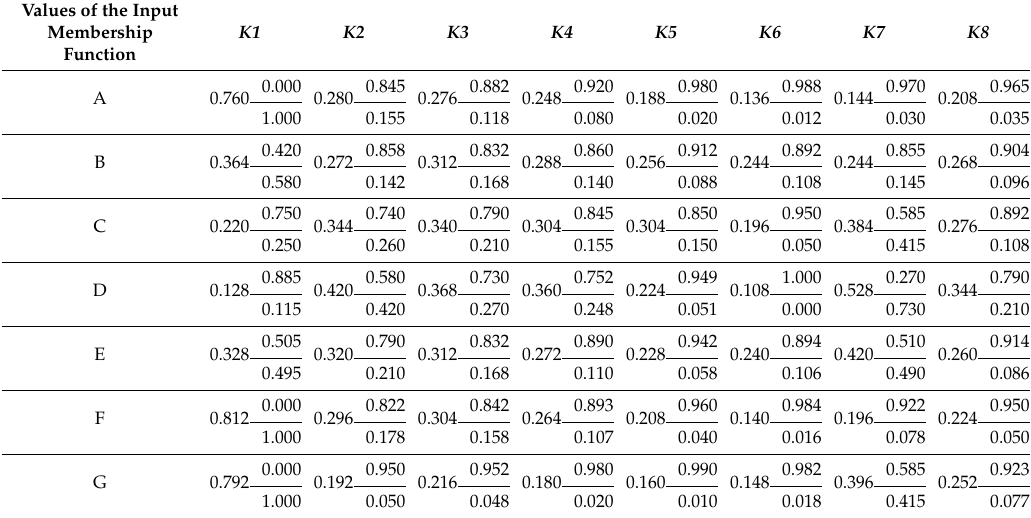
Table 5. The values of the input membership function fuzzy model.